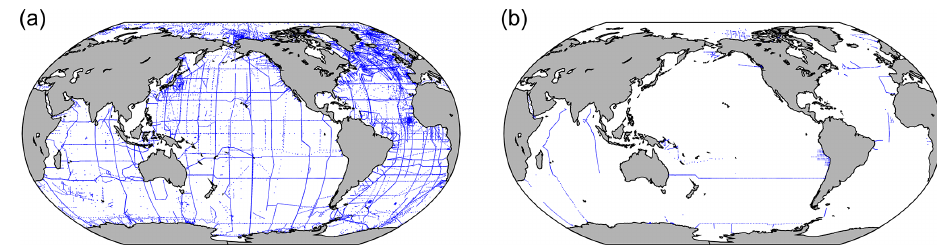
Figure 1. Location of stations in (a) GLODAPv2.2020 and for (b) the new data added in this update.